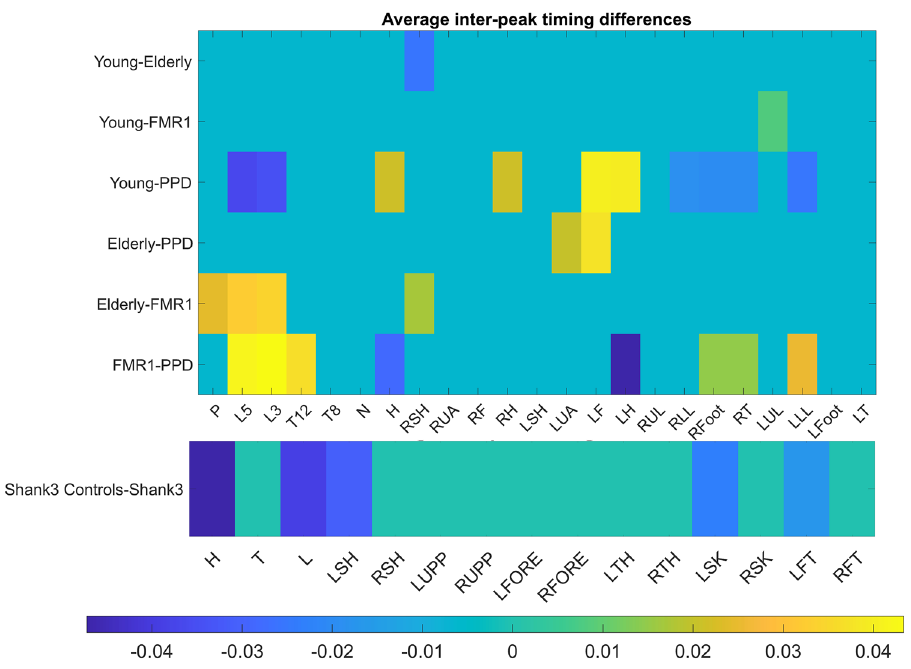
Figure 9. The average differences in inter-peak timings (seconds) taken for each group across all nodes, reveal separation between groups. A difference of zero (cyan color) indicates no significant difference ( p =